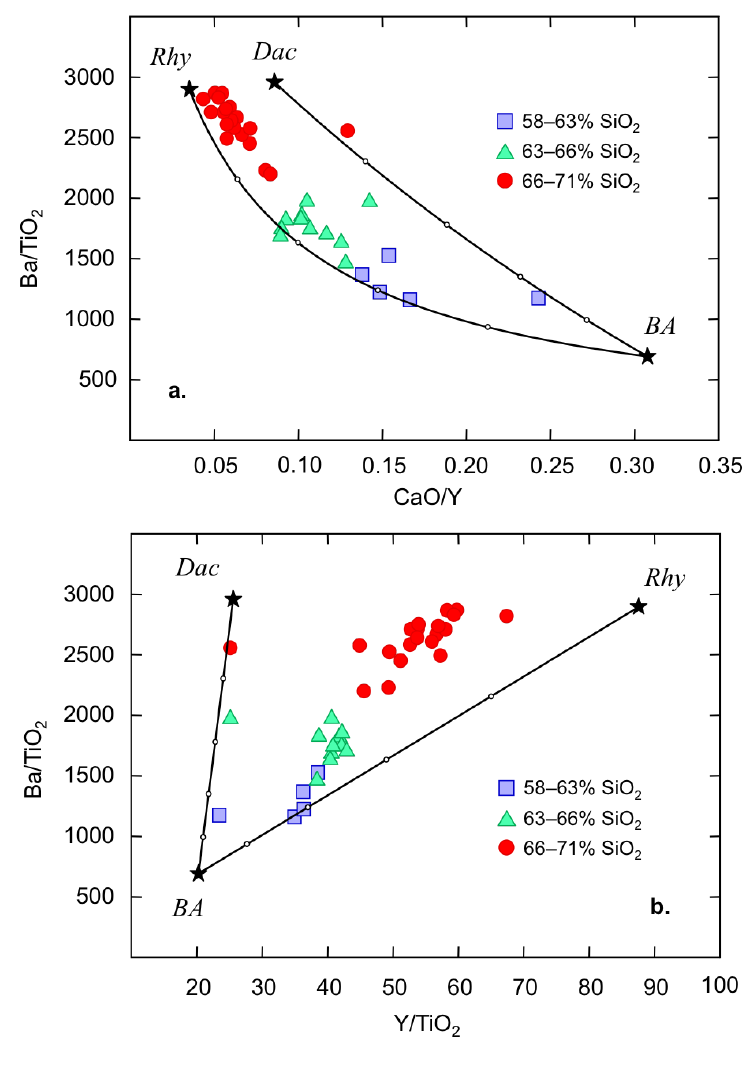
Figure 13. Mixing plots using element ratios for Papagayo samples: ( a ) Ba/TiO CaO/Y; and ( b ) Ba/TiO vs . Y/TiO . Symbols are the same as in previous diagrams. 2 2 PVA-generated end members are shown by stars. In both ( a ) and ( b ), mixing lines are shown in 20% increments of Rhy-BA and